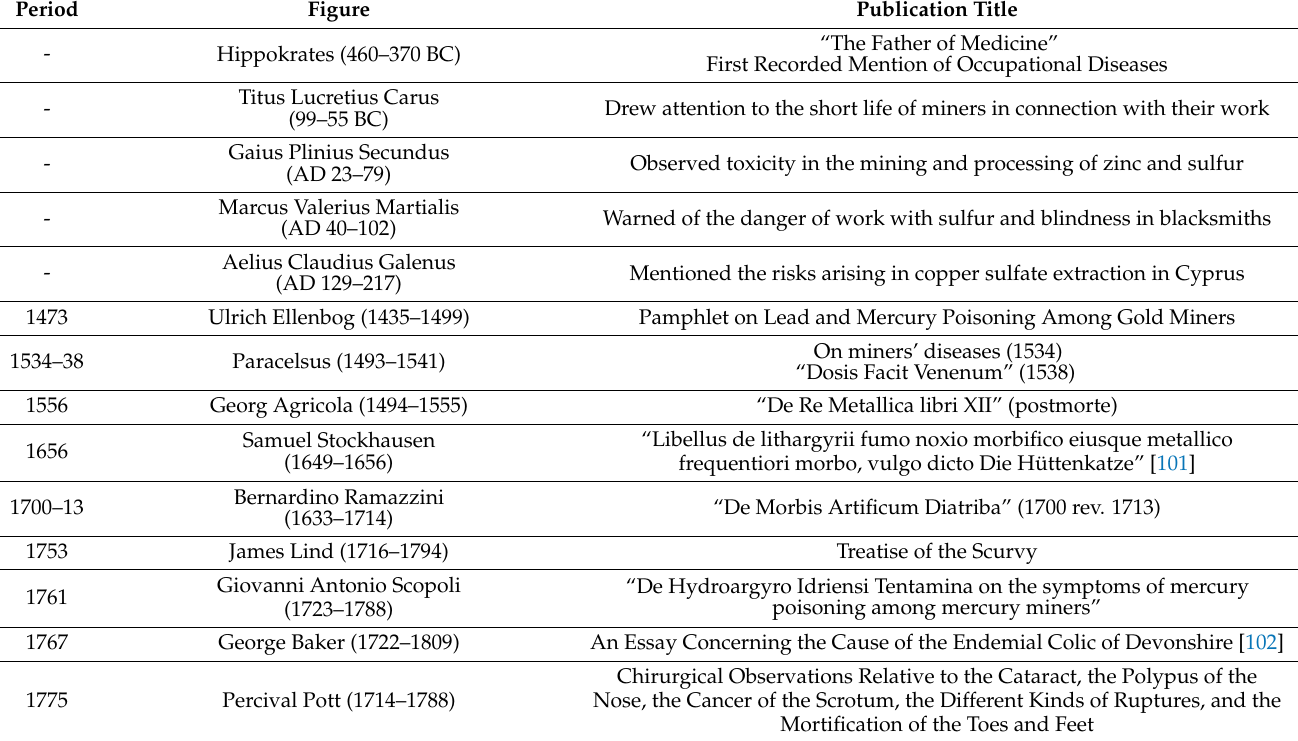
Table 2. Chronology of progress in health care at